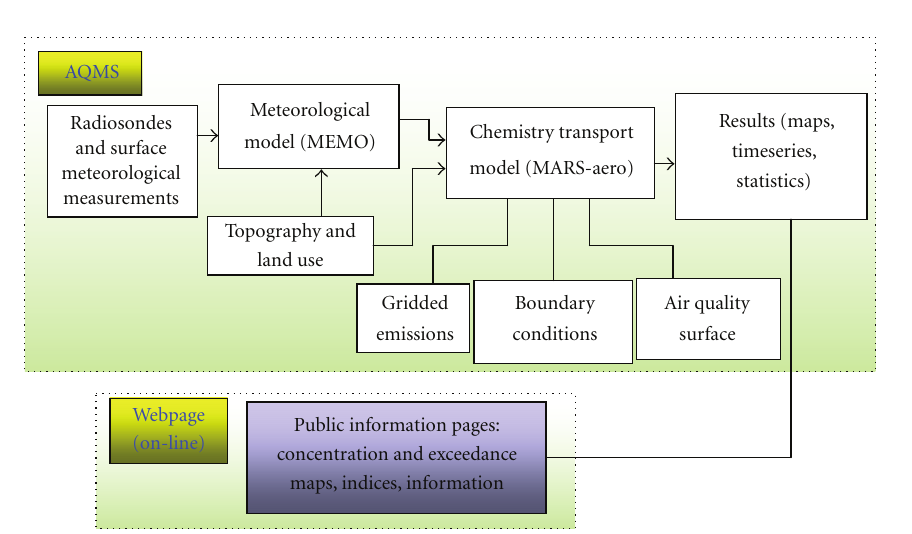
Figure 1: The structure of the air quality management